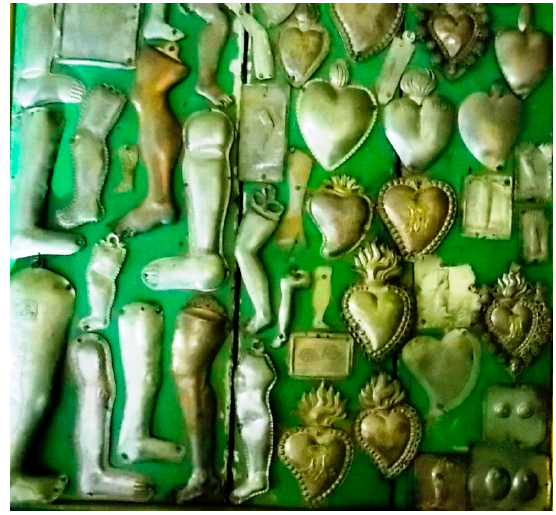
Figure 6. Votive plates, 17th, 18th century, Perast, Church of Our Lady of the Rocks (photo by author). On reliquaries, the majority of ex-votos were found on round surfaces on the top or at the bottom, depending on whether the plate was added to an arm- or leg-shaped container. This particular placement has its own micro history, which can be traced back to the medieval period.